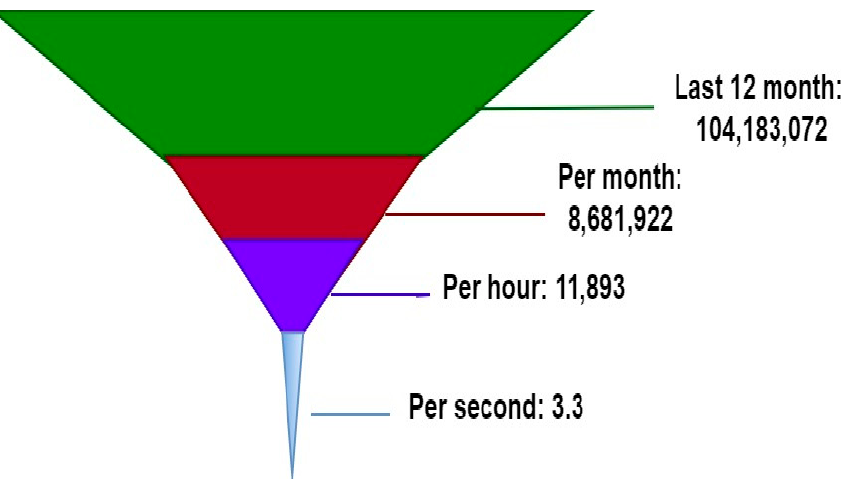
Figure 1. Threats of new malware per second.